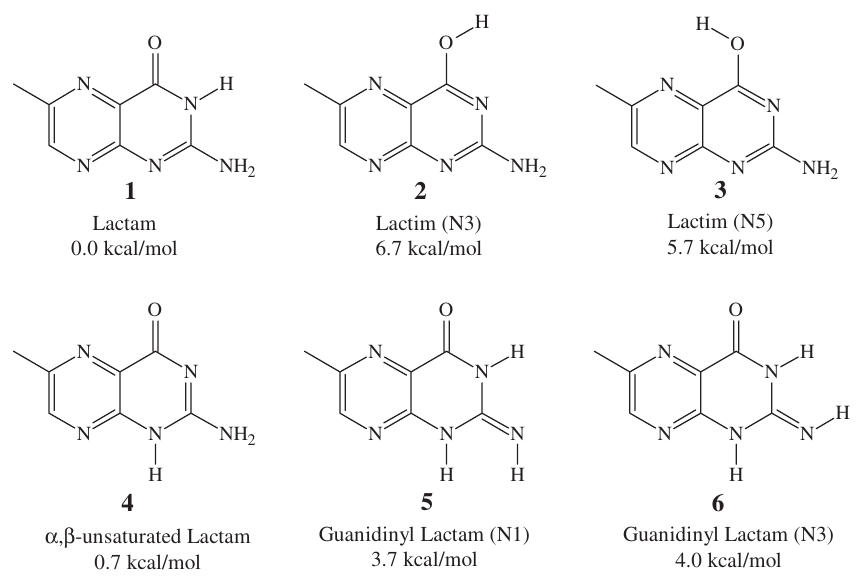
Figure 2 Calculated relative energies of neutral pterin structures [22] (B3LYP/6-21G** level of theory and PCM water dielectric).